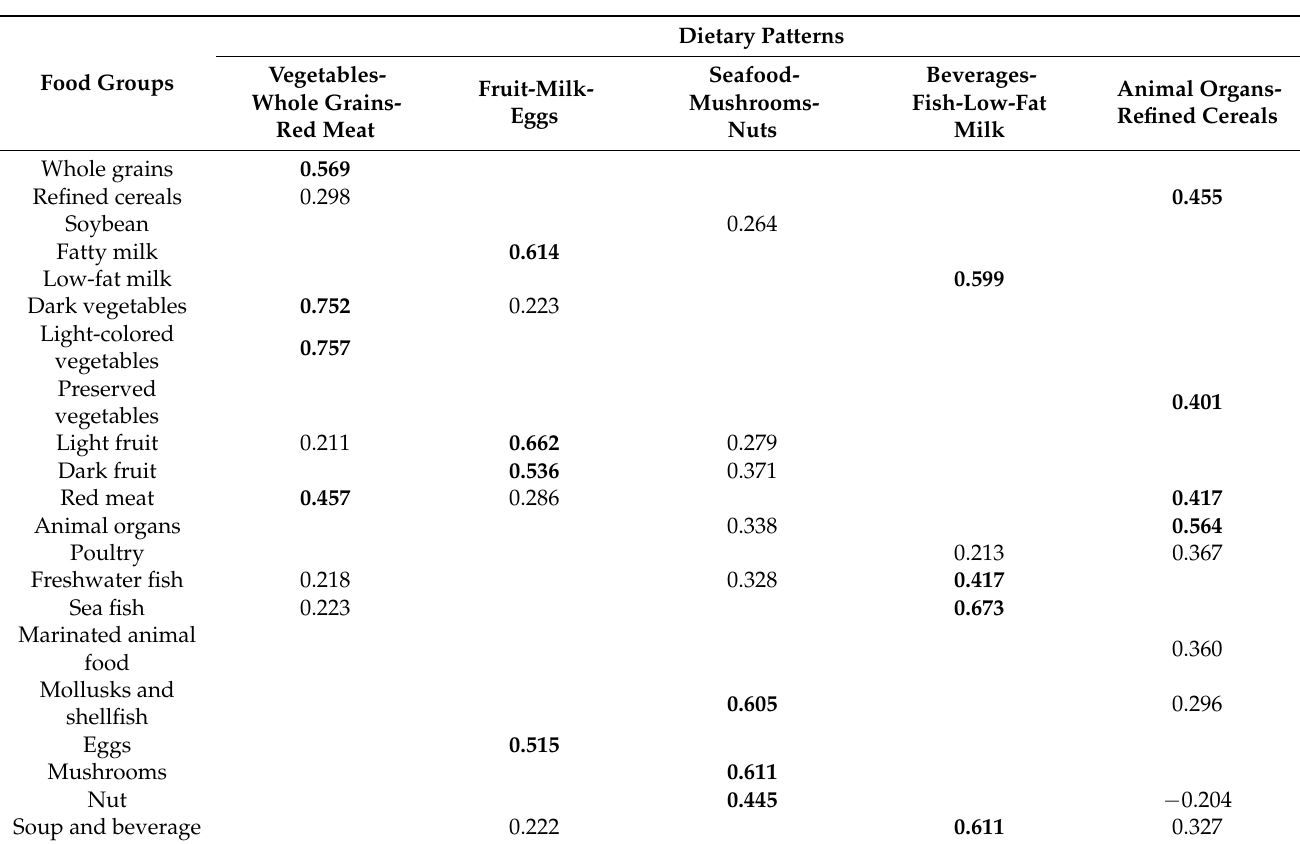
Table 2. Factor loading matrix of dietary patterns by principal component analysis with varimax rotation ( n = 465) *.